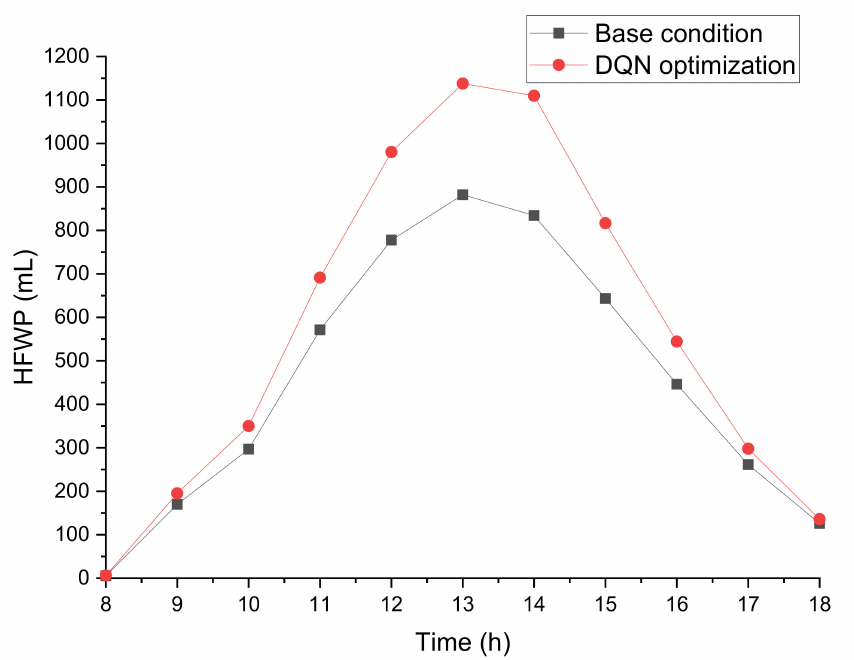
Figure 7. The hourly freshwater production (HFWP)